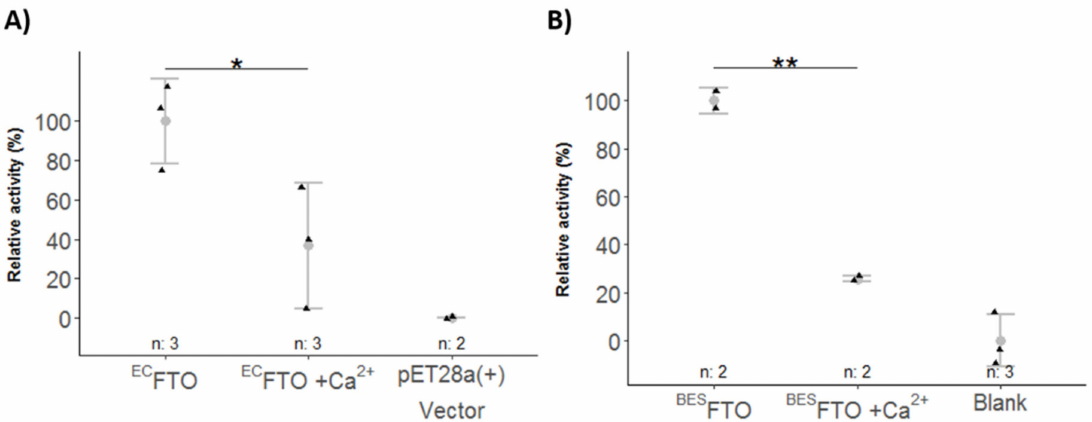
Figure 5. Effect of Ca 2+ on enzymatic activity of FTO by chemiluminescence assay. Relative activity is referenced to the activity of 1 µ g EC FTO ( A ) or BES FTO ( B ) (100%). The N 6 -meA was used as a substrate. Data are represented as points and means, with the whiskers showing sample standard deviation. n—number of samples. ** p < 0.05, * p <